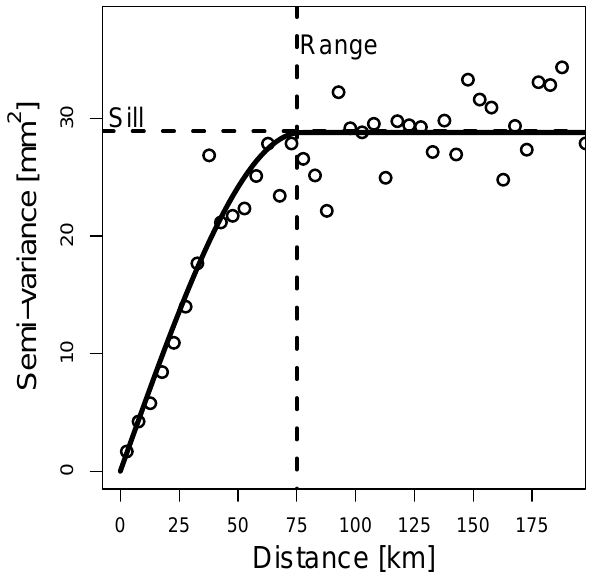
Fig. 3. Example of variogram parameters based on actual data, where the circles represent the binned semi-variance. The solid line is the fitted spherical variogram. The horizontal dashed line is the sill and the vertical dashed line is the